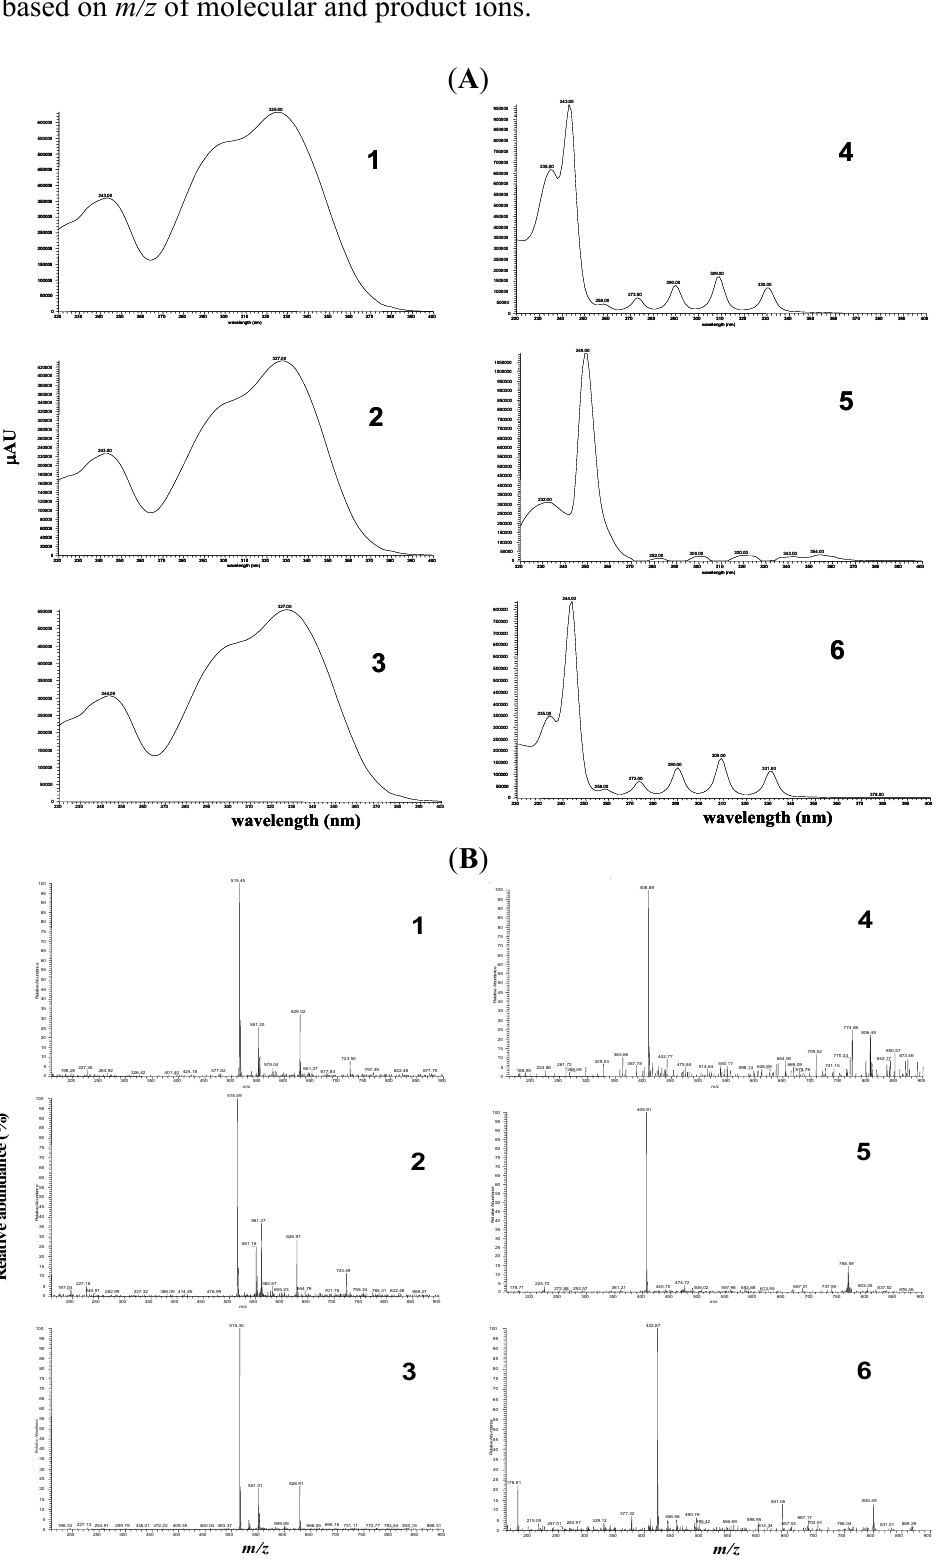
Figure 3. ( A ) UV Spectra (220–400 nm) of three caffeoylquinic acid derivatives (DiCQAs 1, 2 and 3) and three polyacetylenic glucosides (PGAs 4, 5 and 6) showing peaks with similar UV spectra, respectively; ( B ) The mass spectra obtained from a HPLC coupled to negative electrospray ionization (LC-ESI-MS) (DiCQAs 1, 2 and 3) and negative atmospheric pressure chemical ionization mass spectrometry (LC-APCI-MS) (PGAs 4, 5 and 6) based on m/z of molecular and product